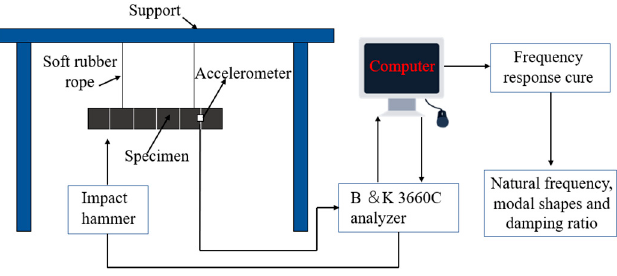
Figure 8. Exciting points division and accelerometer layout of the CFRP laminate.